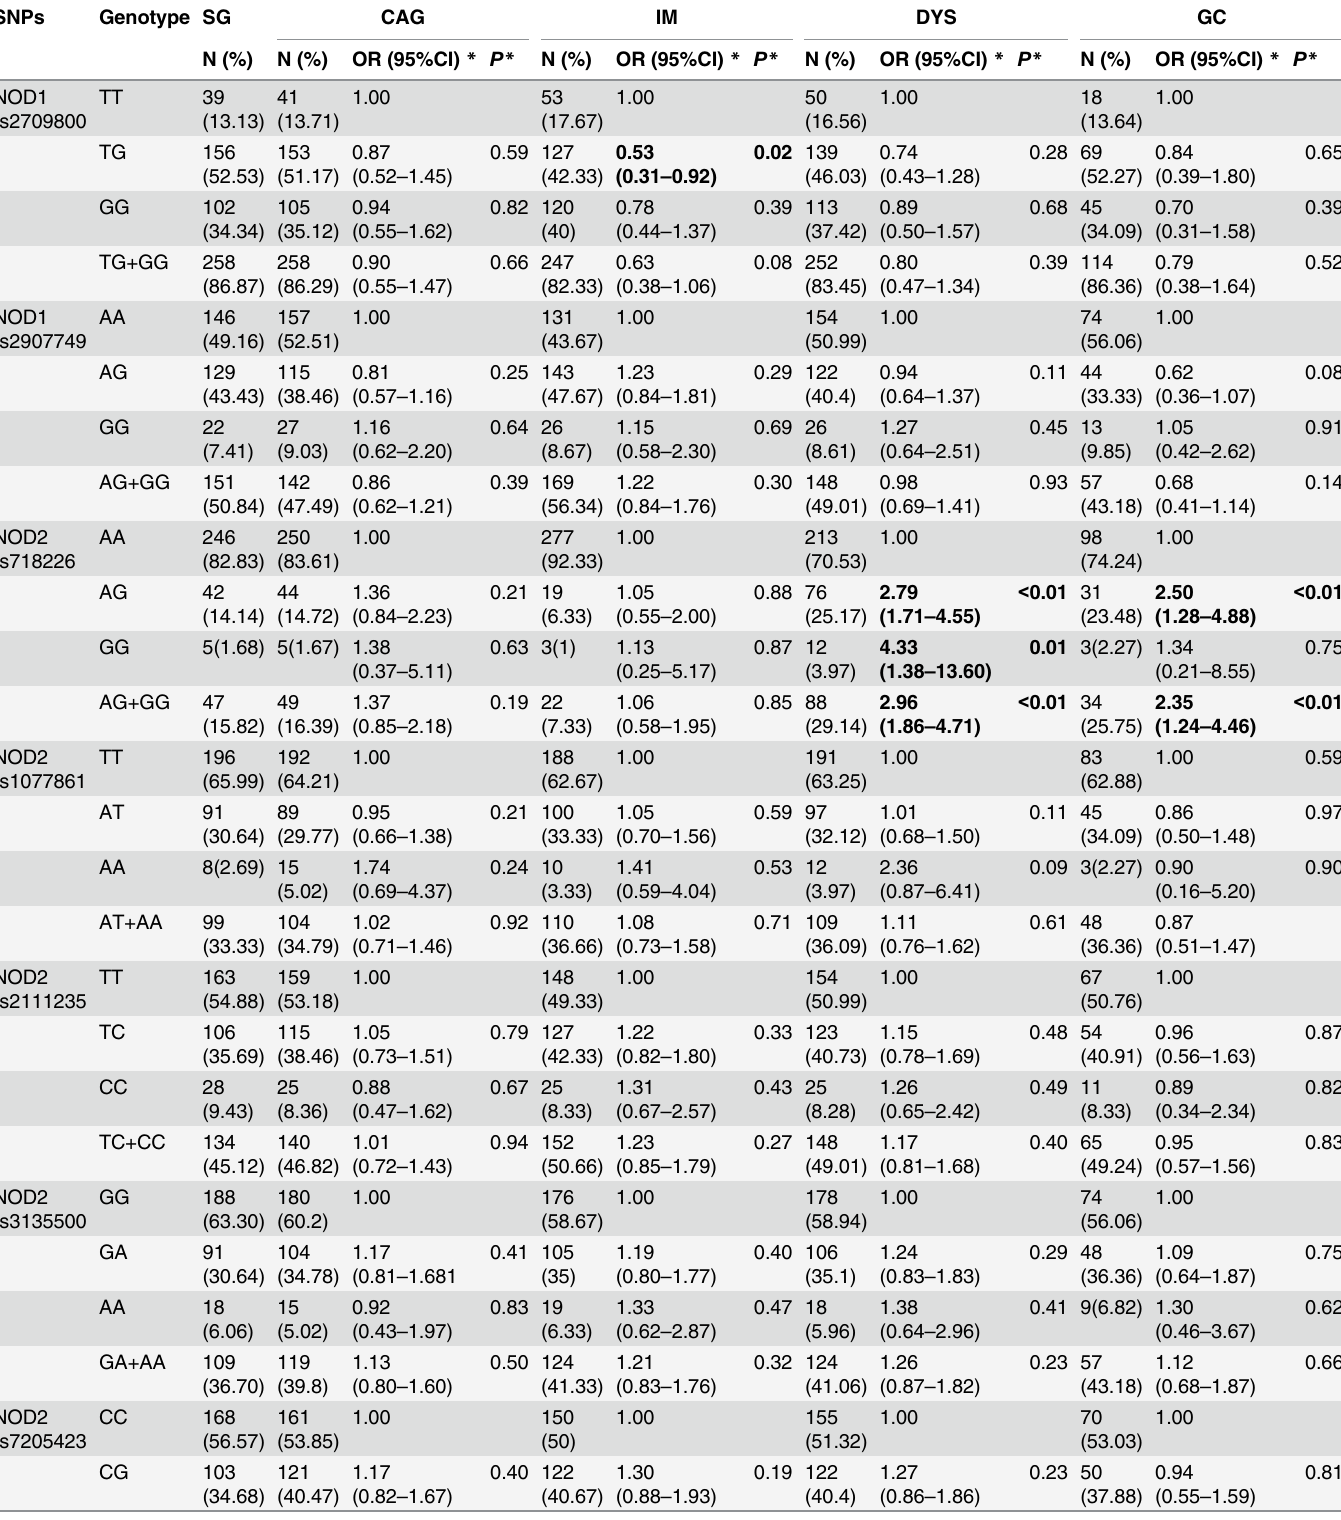
Table 2. Risk of precancerous gastric lesions and GC associated with NOD1 and NOD2